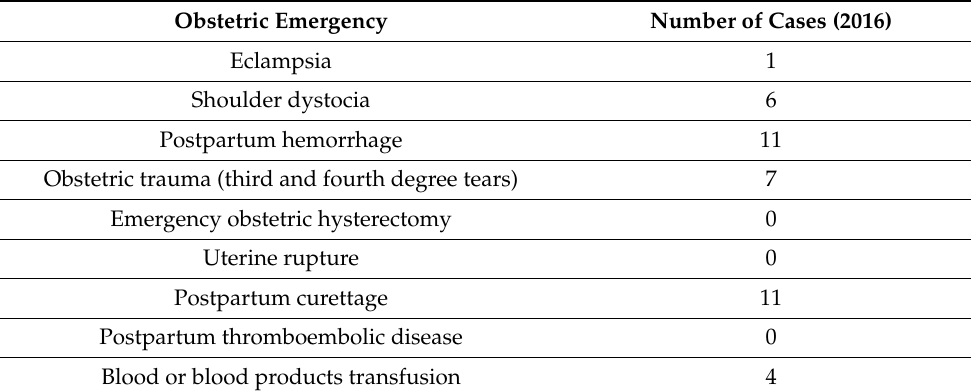
Table 4. Obstetric emergencies at the Hospital of Torrevieja in 2016.